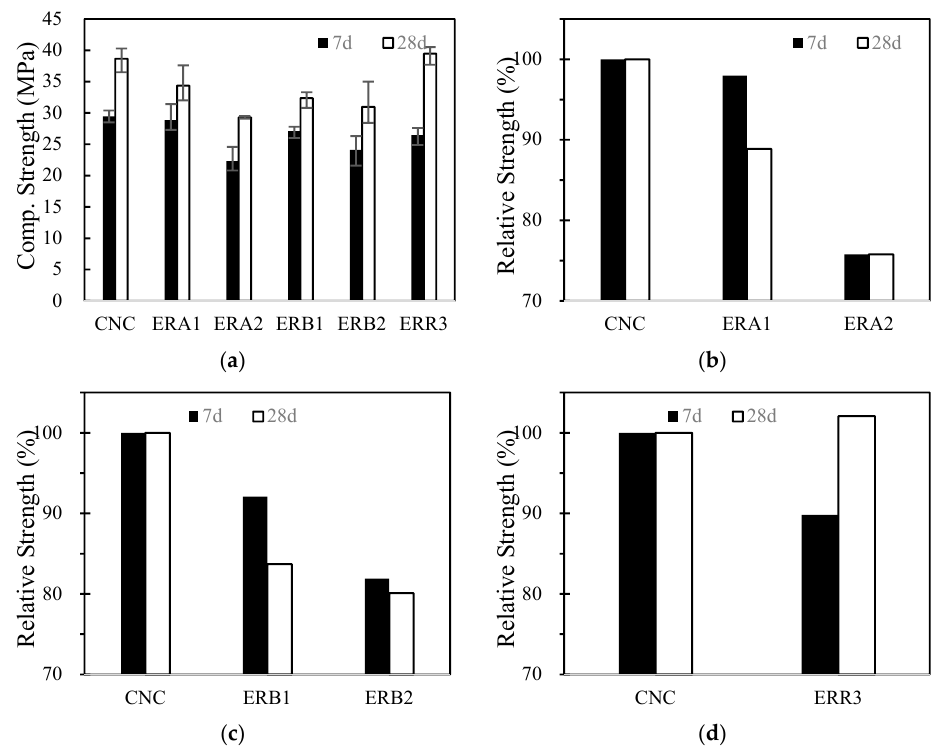
Figure 6. Compressive strength results of concrete samples ( a ) strength, ( b ) relative value of ERA series, ( c ) relative value of ERB series, and ( d ) relative value of ERR mix.